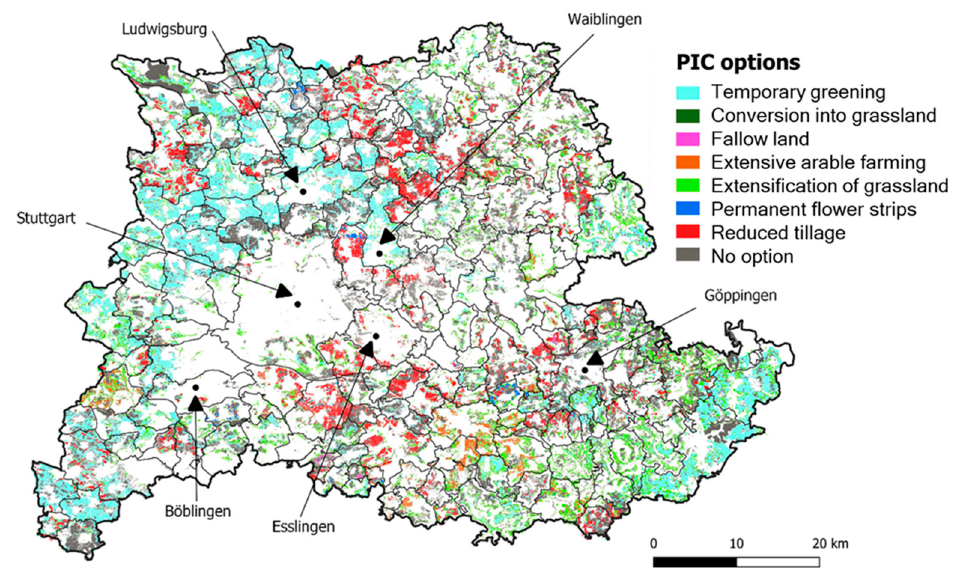
Figure 6. PIC map from the agricultural perspective illustrating the priority option based on the IACS data and BKG [36]